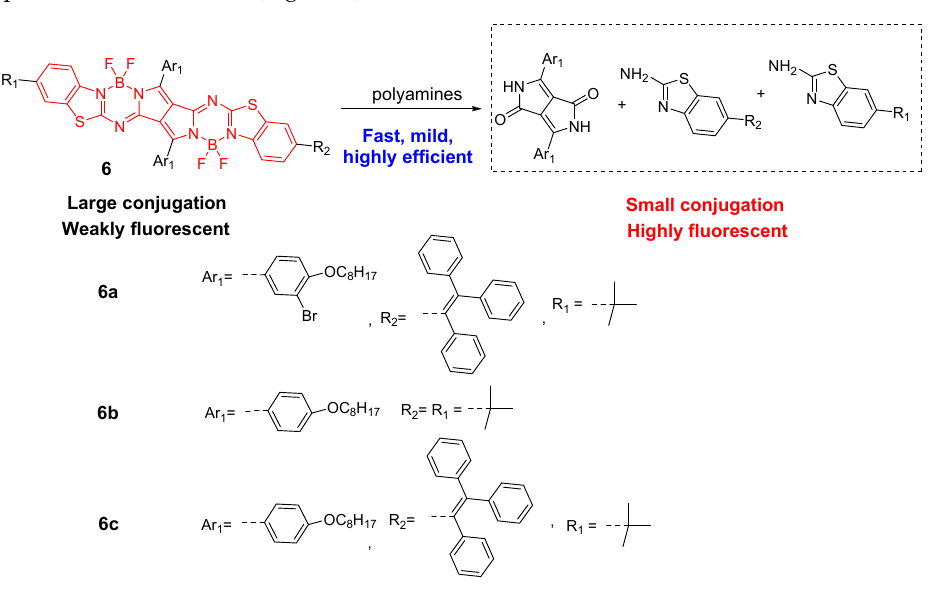
Figure 7. The possible sensing mechanism between compound 6 and polyamines [62]. Figure 8. The possible sensing mechanism between compound 7 and polyamines [63].